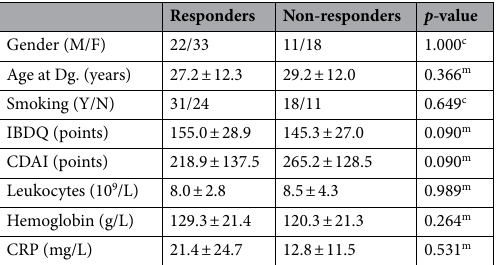
Table 5. Baseline demographics of included patients. c Fisher exact test; m Mann–Whitney